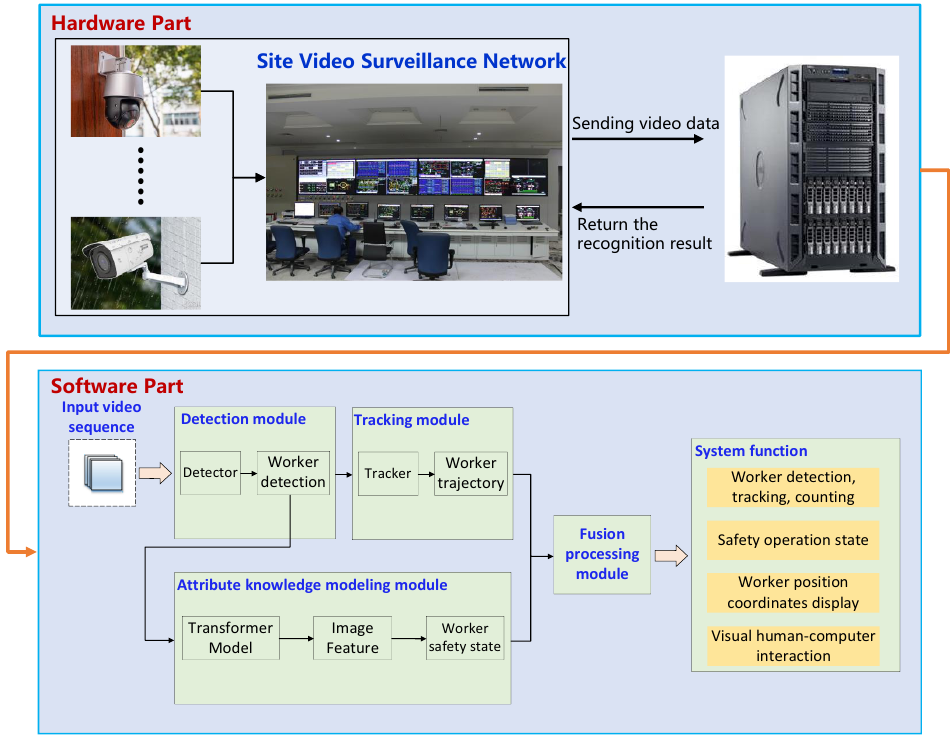
Figure 1. The framework of our proposed system. The system is divided into the hardware part and the software part. The hardware part is used to send input video data and display the recognition results; the software part is used to intelligently process video and